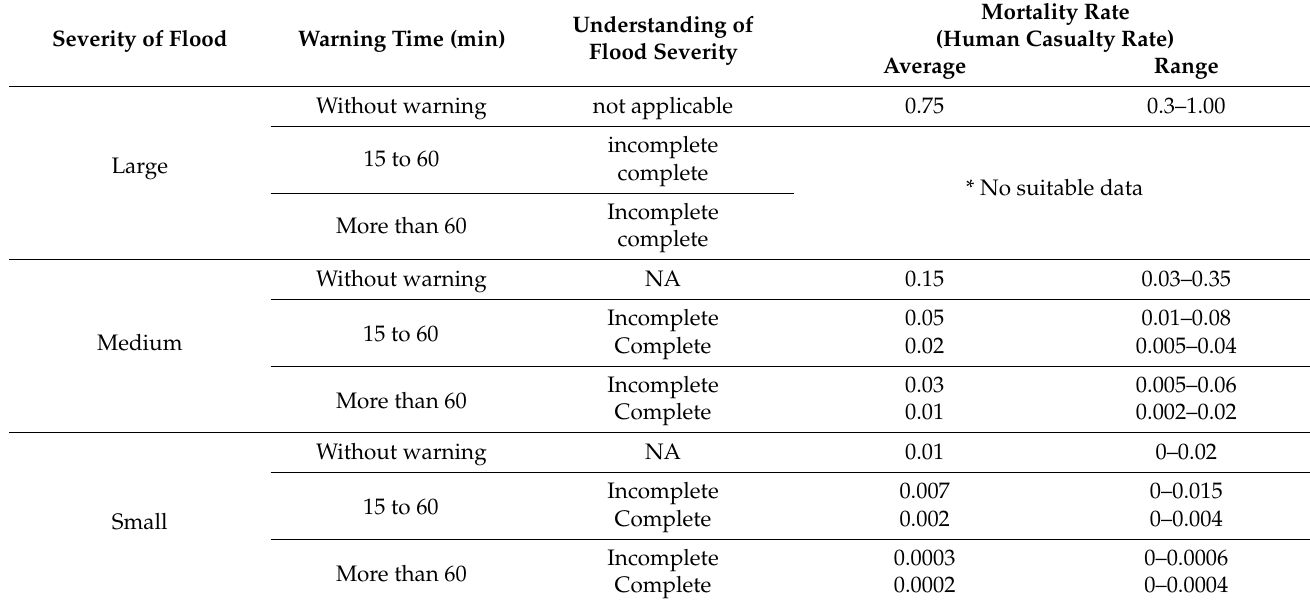
Table 2. Proposed mortality rates for the calculation of potential human casualties in the event of dam failure [29]. Reproduced with permission from publisher Bureau of Reclamation Dam Safety Office Denver, Colorado, A Procedure for